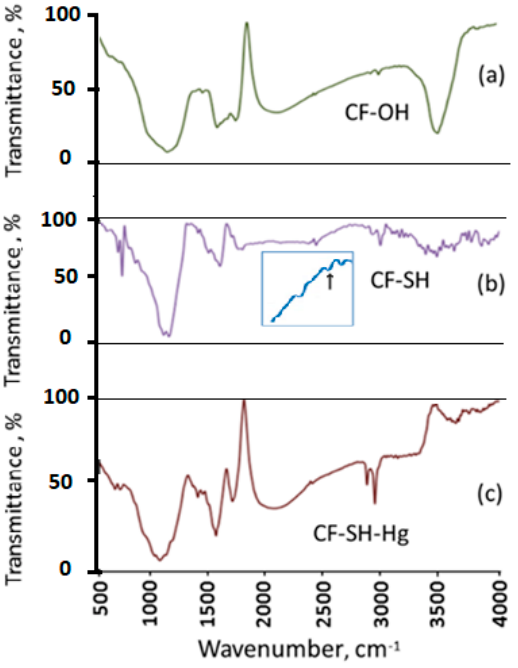
Figure 2. IR spectra of ( a ) CF-OH, ( b ) CF-SH, and ( c ) CF-SH-Hg.